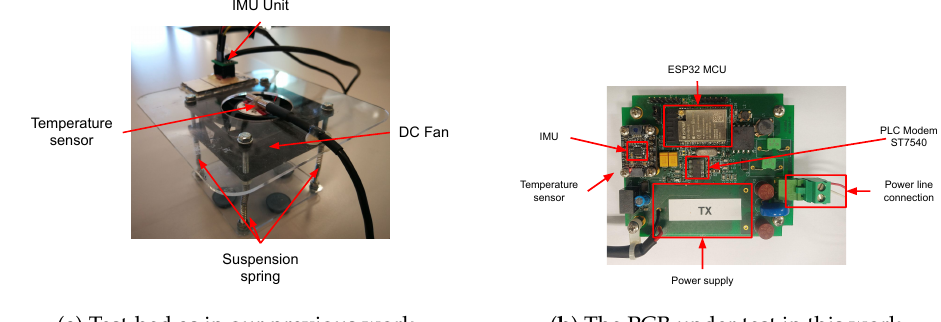
Figure 4. Test-bed devices built. ( a ) is the test-bed built in [13] to validate the proposed solution comprising an IMU to sample vibrations, a temperature sensor to sample the fan engine temperature, a PC 12v DC fan, and a suspended structure over springs that function asa vibrating simulator. ( b ) is the PCB board under test in this work before the deployment inside the underwater pump. The board carries the ESP32-ROVER-IE board with the MCU, the ST7540 PLC Modem, the ICM-20948 IMU mounted over a break-out board by Adafruit, the temperature sensor placed below the IMU board, the power-line connector, and the power supply unit (PSU), missing in this